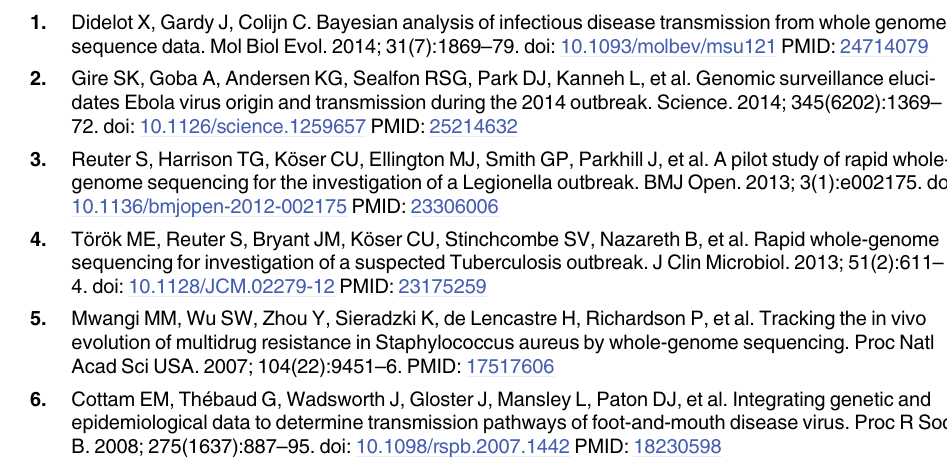
S1 Table. Comparison of features in seedy and outbreaker . Both R packages are publicly available on CRAN, and offer simulation of genomic and epidemiological data during infec- tious disease outbreaks, as well as functions to infer transmission